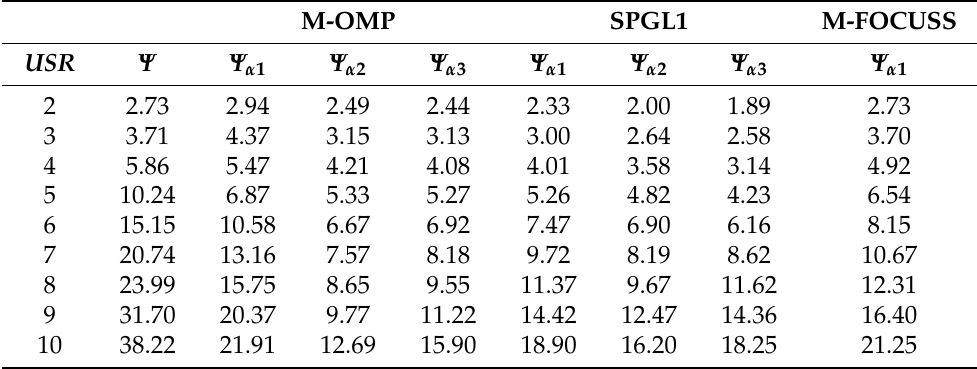
Table 7. Comparison of PRD values from the algorithms using the three dictionary matrices at several USR values, for ECG signal No.